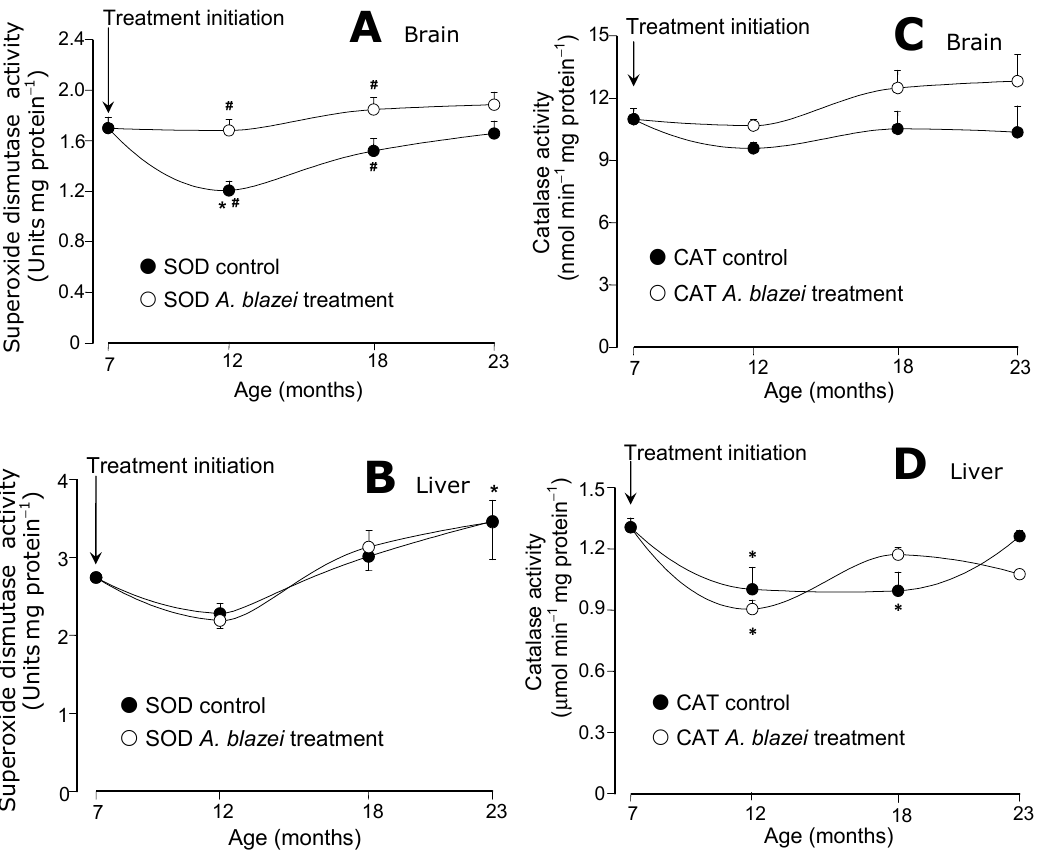
Figure 4. ( A ) Superoxide dismutase (SOD) activities of brain homogenates. ( B ) Superoxide dismutase (SOD) activities of liver homogenates. ( C ) Catalase (CAT) activities of brain homogenates. ( D ) Catalase (CAT) activities of liver homogenates. The data points represent the means ± mean standard errors of five to seven animals. The statistical analysis consisted of MANOVA followed by Duncan’s multiple range post hoc testing. Data points labeled with asterisks (*) are values significantly different ( p ≤ 0.05) from those found at 7 months (treatment initiation). Statistically different pairs of values for a given age are labeled with hashes